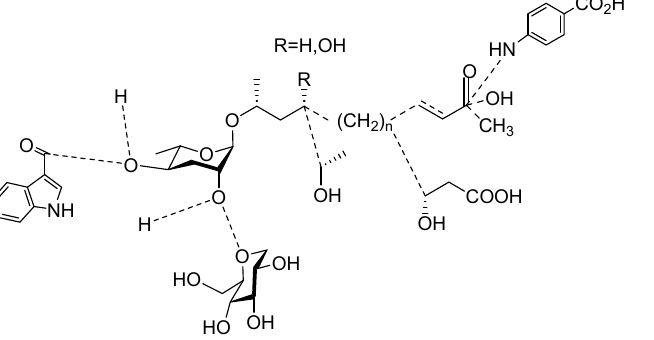
Figure 2. Overview of the chemical structures of sex pheromones secreted by nematodes. Vanillic acid does not have an ascaroside structure, so it is not shown here, and its detailed structure is presented in Table 1.